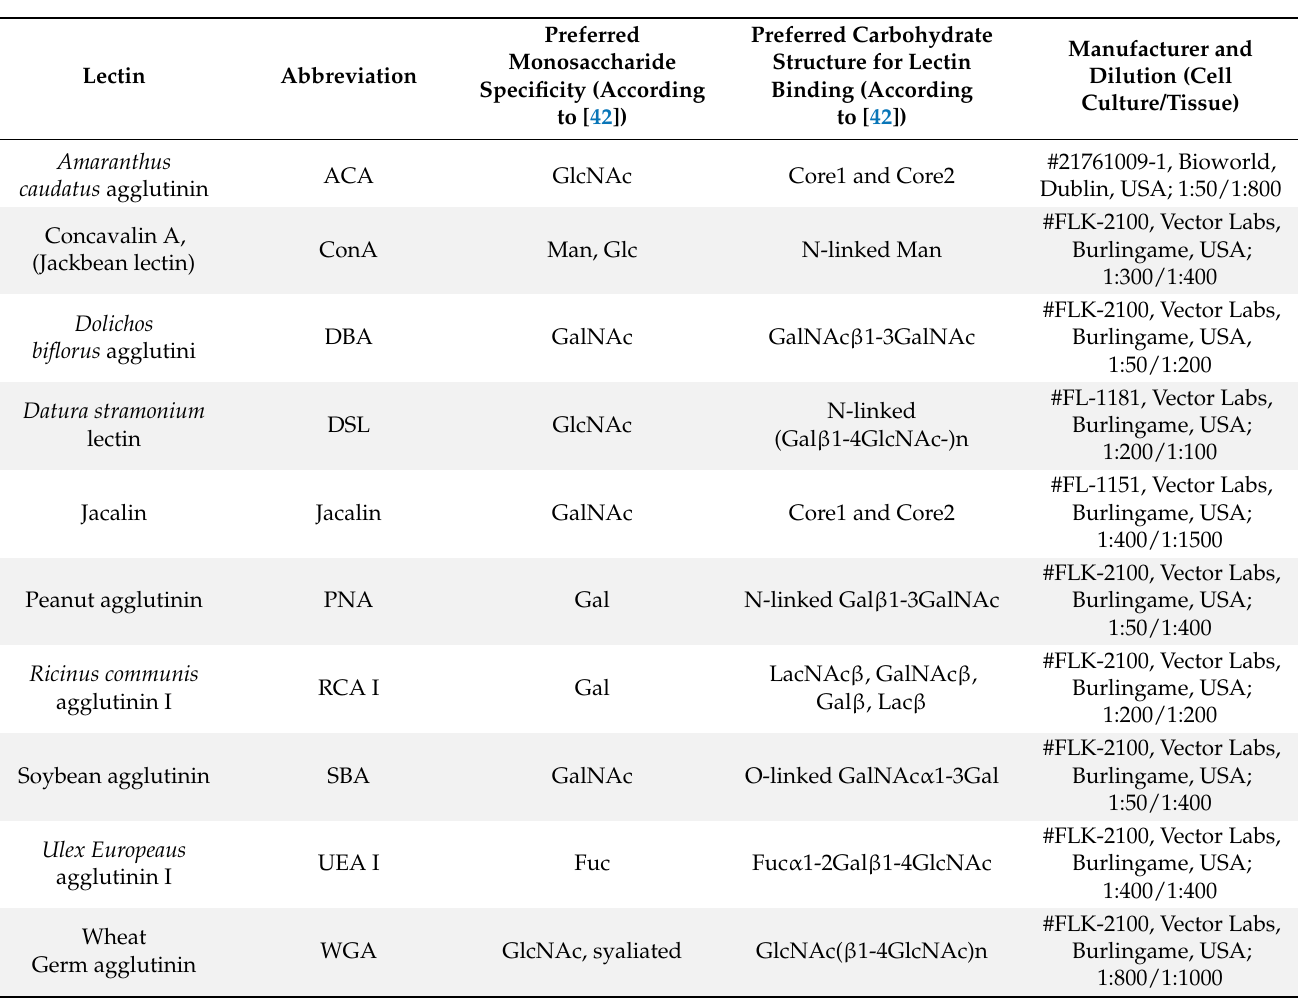
Table 1. The lectins used in the experiments. The preferred sugar specificity, preferred carbohydrate structure for lectin binding, manufacturers, and dilutions are listed. The optimal dilutions for each lectin were determined in preliminary